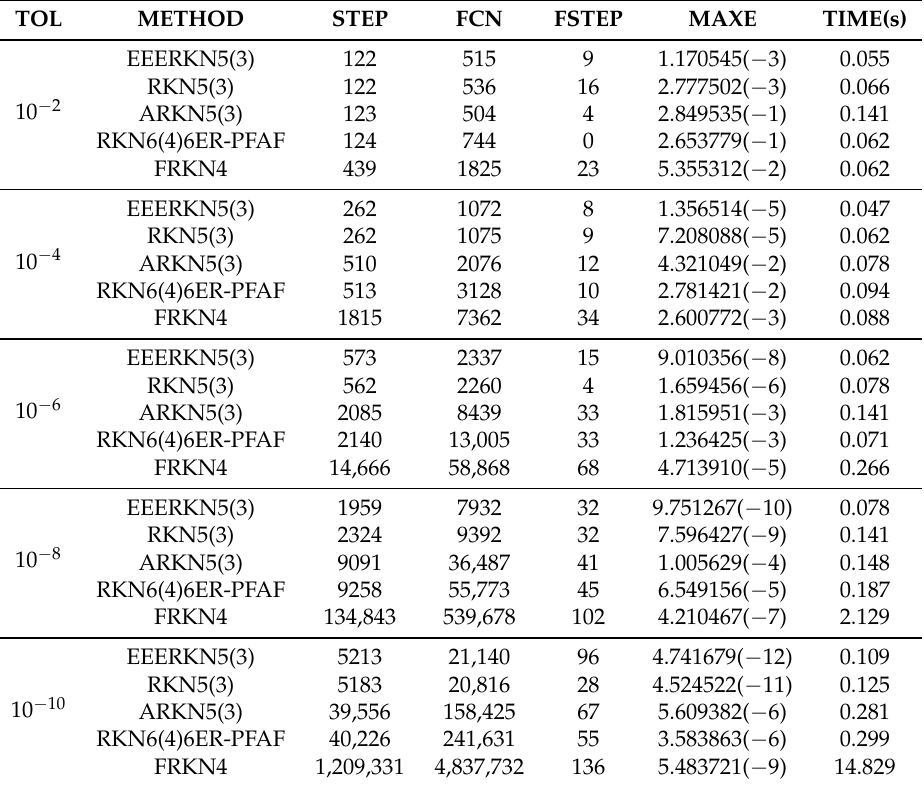
Table 5. Numerical results for Problem 4.